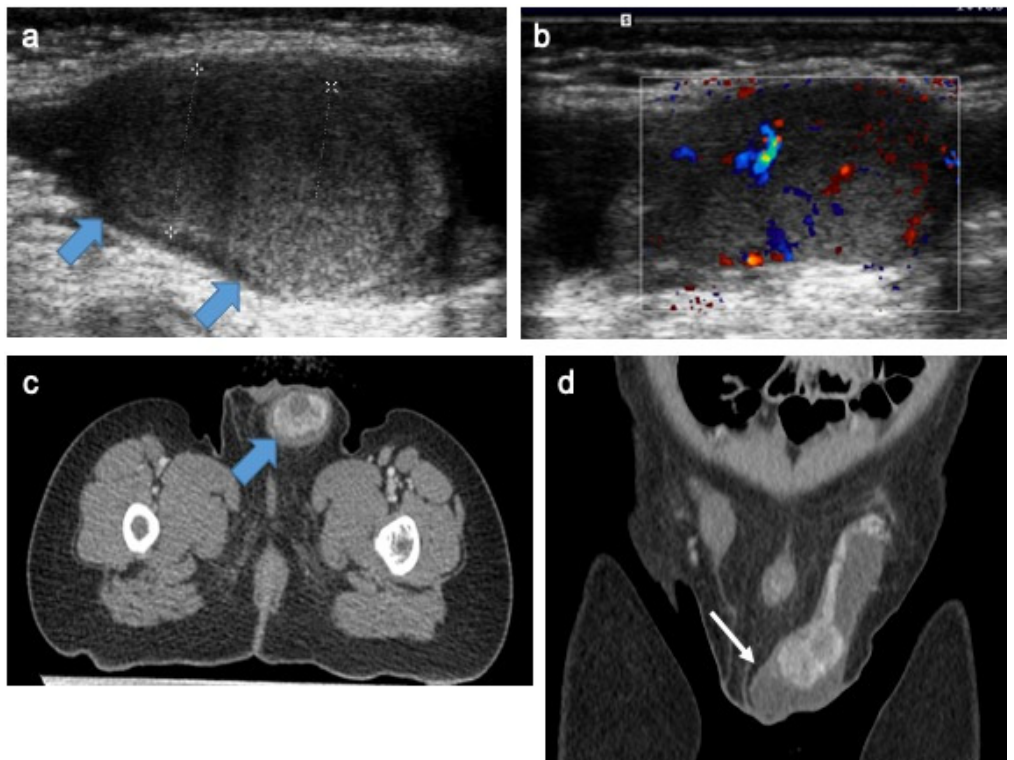
Figure 3. Intra-testicular yolk-sac tumor in a 20-month-old boy. Longitudinal gray-scale B mode ( a ) and transverse color Doppler ( b ) US of the testis. Staging contrast-enhanced CT focused on the pelvic on axial ( c ) and coronal ( d ) views. Images demonstrating two solid intra-testicular masses with color Doppler signal and heterogeneous enhancement after contrast (blue arrow), surrounded by peritesticular effusion (white arrow). AFP level was high and inguinal orchidectomy was performed. US, ultrasonography; AFP, alpha-fetoprotein. Courtesy of Dr Brisse and Dr Cardoen, Institut Curie, Paris, France.